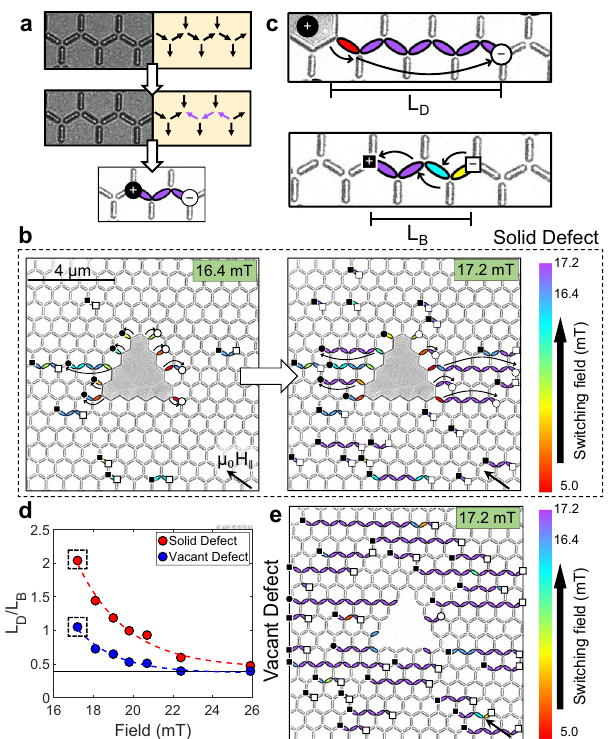
Fig. 1 Monopole nucleation in DASI. a Under-focused LTEM micrograph (left sub-panel) and schematics (right sub-panel) of Kagomé vertex junctions before and after monopole-antimonopole (MP-AMP) nucleation (top and center panels, respectively); bottom panel, an example of labeled LTEM where switched macrospins are represented by ellipses whose color shows their respective switching fi eld; MP-AMP charges are drawn for reference. b Labeled LTEM image at in-plane fi elds μ 0 H ‖ = 16.4 mT and μ = 17.2 mT (left and right panels, respectively) of the solid DASI 0 H ‖ undergoing fi eld reversal; MPs that nucleate at the defect-ASI interface are represented as circles, whereas those that form spontaneously are represented by squares; curved arrows represent the defect-bound MP propagation direction. c Labeled LTEM image with representations of defect-dependent and independent MP propagation (top and bottom panels, respectively), where the respective Dirac string lengths (L D and L B ) are indicated. d Mean L D /L B ratio at increasing fi eld magnitude for the solid DASI and a lattice with a vacant defect e . Lattices depicted in b (right panel) and e are indicated in d by the